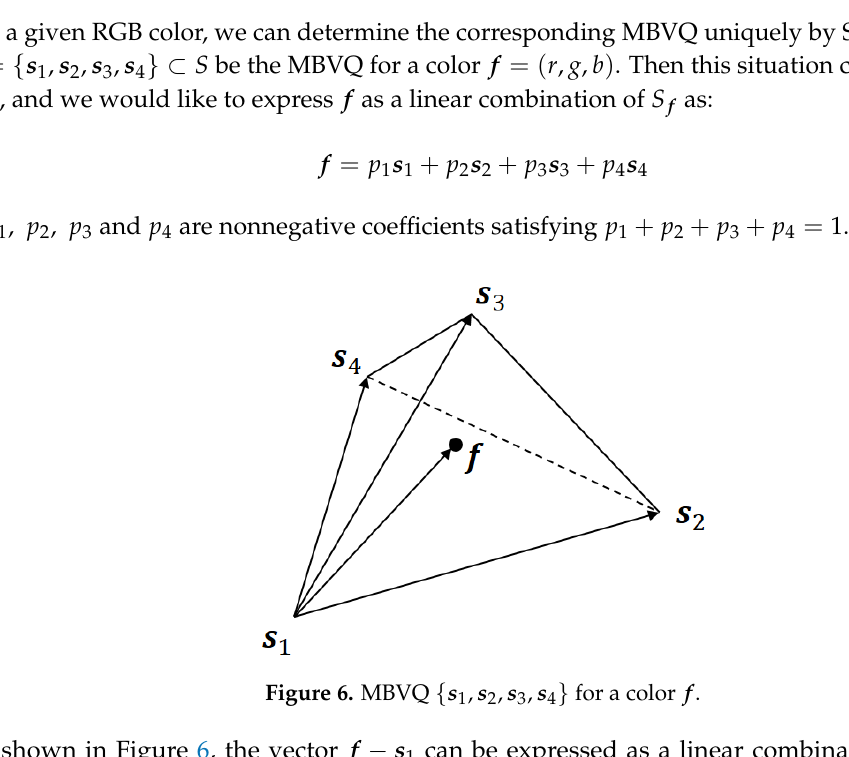
Figure 5. Eight basic colors ordered on the brightness axis.